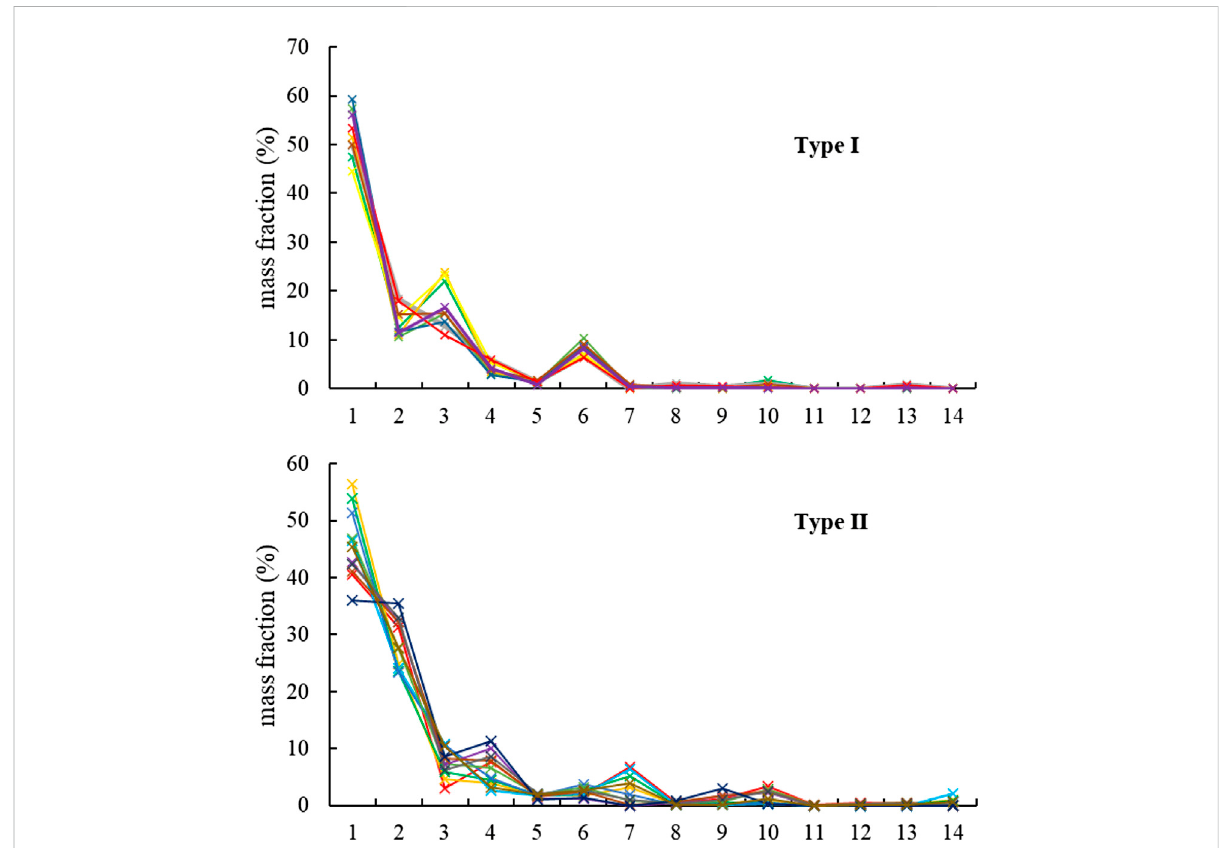
FIGURE 4 ThecompositioncharacteristicsofaromatichydrocarbonsincrudeoilfromtheEastFukangSag.Notes:1)Naphthaleneseries,2)Phenanthrene series, 3) Biphenyl series, 4) Fluorene series, 5) Dibenzothiophene series, 6) Dibenzofuran series, 7) Triaromaticsteroid series, 8) Fluoranthene series, 9) Pyrene series, 10) Chrysene series, 11) Benzo fl uoranthene, 12) Benzopyrene series, 13) Benzo fl uorene series, 14)